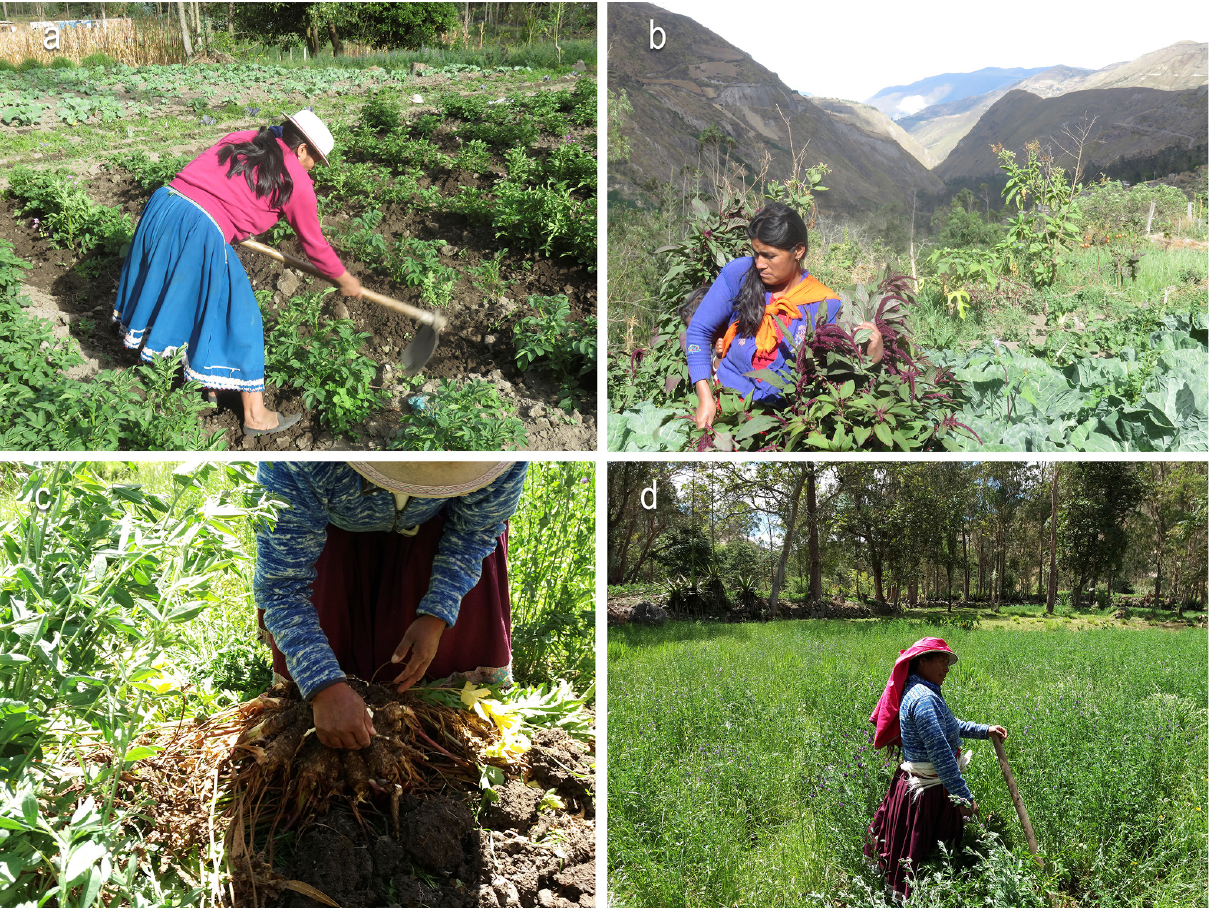
Figure 7. Agroecological cropping systems of the Nizag community. ( a ) Agustina Saquisilí in the agriculture system; ( b ) María Tenesaca in the horticulture system; ( c ) María Mendoza in the man- culture system; ( b ) Mar í a Tenesaca in the horticulture system; ( c ) Mar í a Mendoza in the management agement system; ( d ) María Morocho in the cultural control system. system; ( d ) Mar í a Morocho in the cultural control